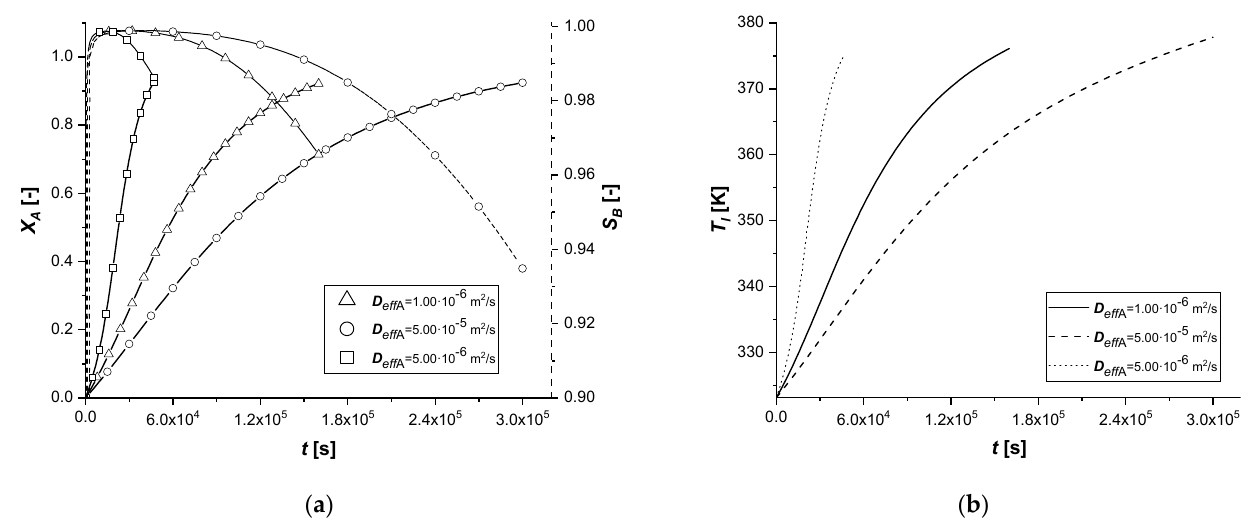
Figure 19. EY D eff,A investigation. ( a ) Bulk profiles over time of X A and S B . ( b ) Bulk profile of T l over time.